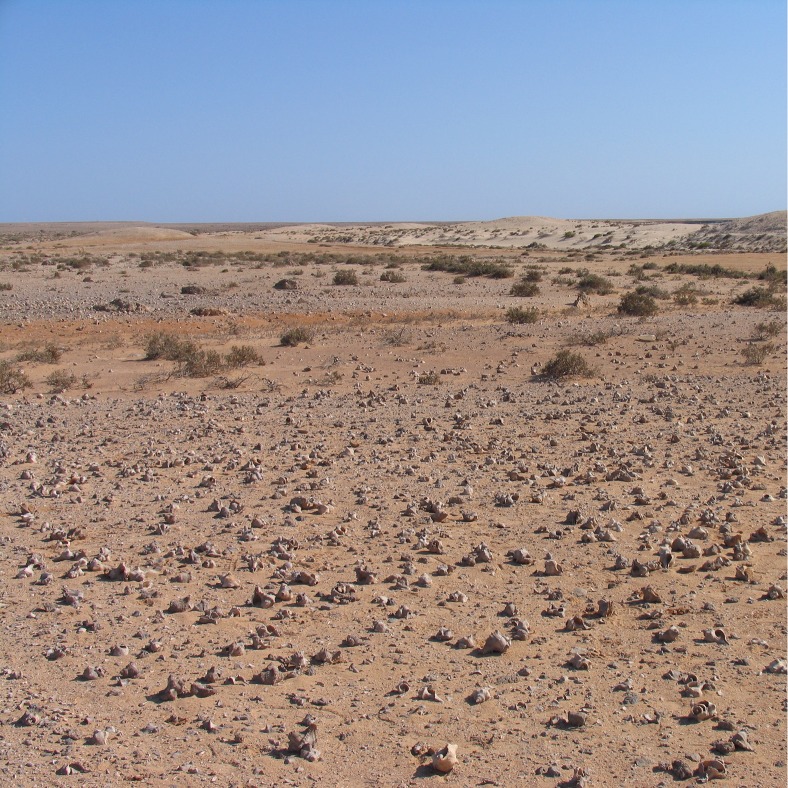
Deflated post-shore site in foreground comprised mainly of shells of the large mollusc, Chicoreus ramosus.A second shell scatter is visible in the left middle distance (JE5641). Photograph taken facing South, the large shell mound JE0086 on the main shore is visible in the distance to the right (with a trigonometrical pillar on its summit). A row of shell mounds on the main shoreline extends to the left of JE0086 (see also Fig 6) and a row of peak shoreline sites (incl. JE0087) is found to the far left of the image (see also Fig 3). Photo by Geoff Bailey, May 2006.